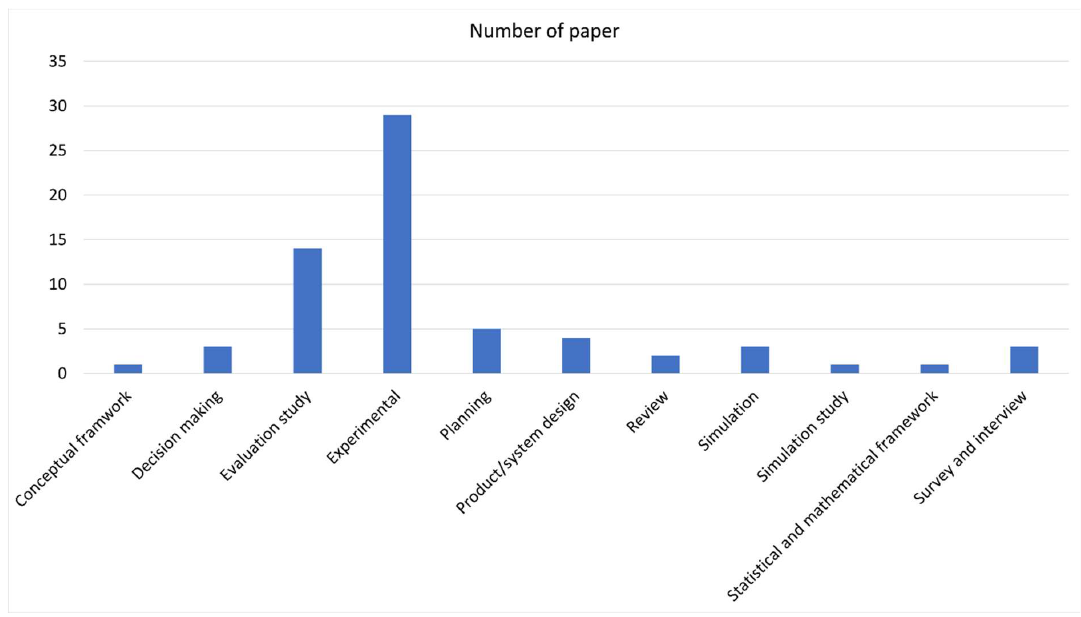
Figure 5. Main research focus of the articles (Years of analysis: 2017–January 2022).